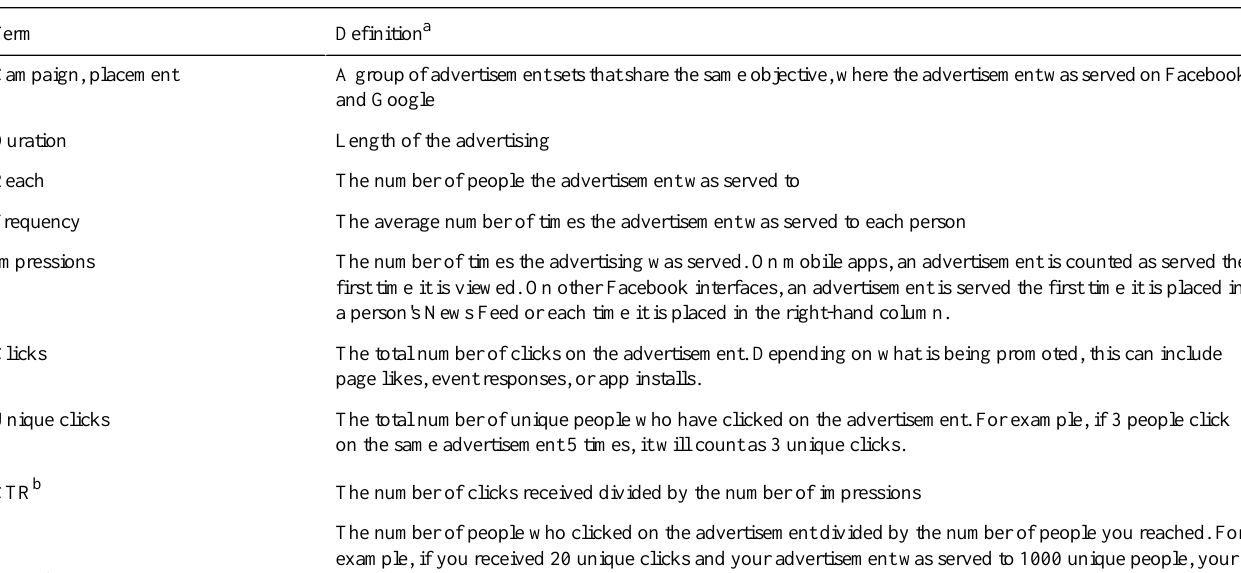
Table 4. Facebook and Google TXT2BFiT advertisement data